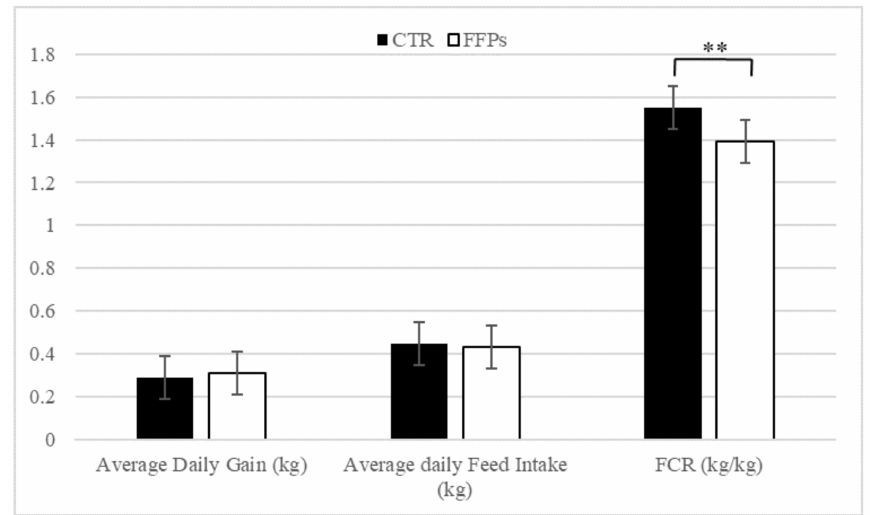
Figure 2. E ff ects of partial replacement of conventional cereals by FFPs on growth performances. CTR = standard diet; FFPs = former foodstu ff s products diet; FCR = feed conversion ratio; Value for each item is the mean ± SEM (standard error of the mean); ** Values di ff er significantly at p <